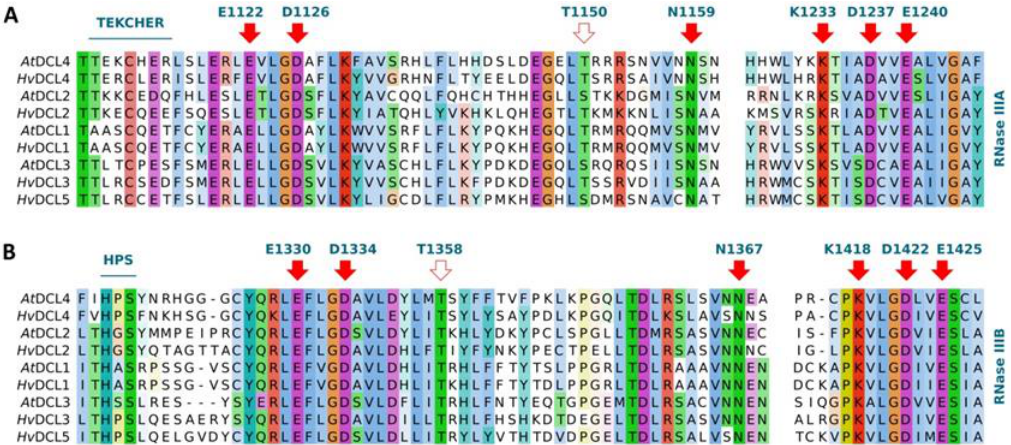
Figure 5. Conservation of functionally critical amino acids between A. thaliana and barley DCL proteins. Conserved residues involved in enzyme catalysis within ( A ) Rnase IIIA (E1122, D1126, N1159, K1233, D1237, E1240, red arrow), ( B ) RNase IIIB (E1330, D1334, N1367, K1418, D1422, E1425, red arrow), and ( A , B ) RNA-binding motifs (TEKCHER, HPS loops and T1150, T1358 residues, blue line and open arrows). Residue numbers correspond to AtDCL4 amino acid positions. For full-length alignment of DCLs see Figure S1.